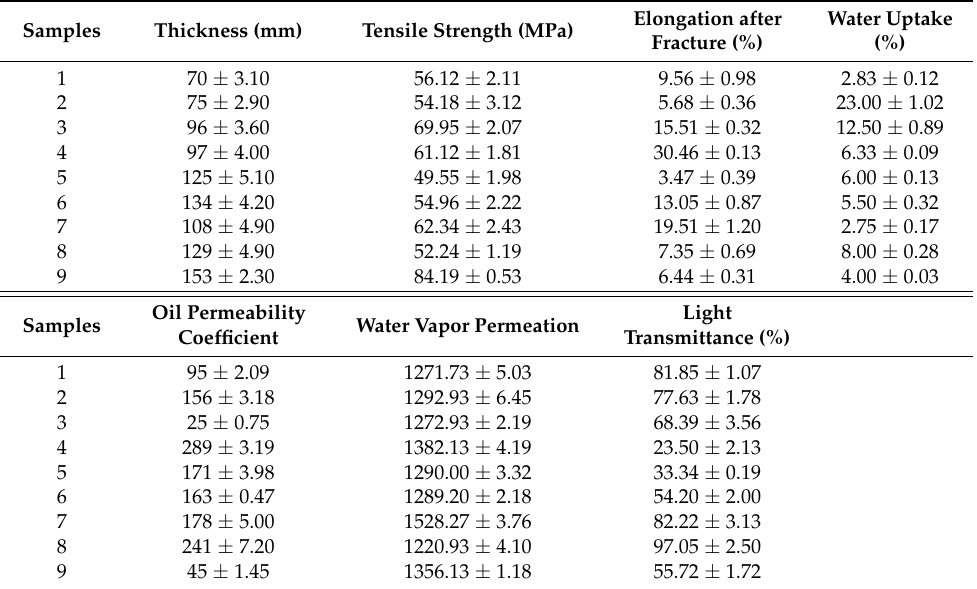
Table 4. The raw data of orthogonal experimental test.